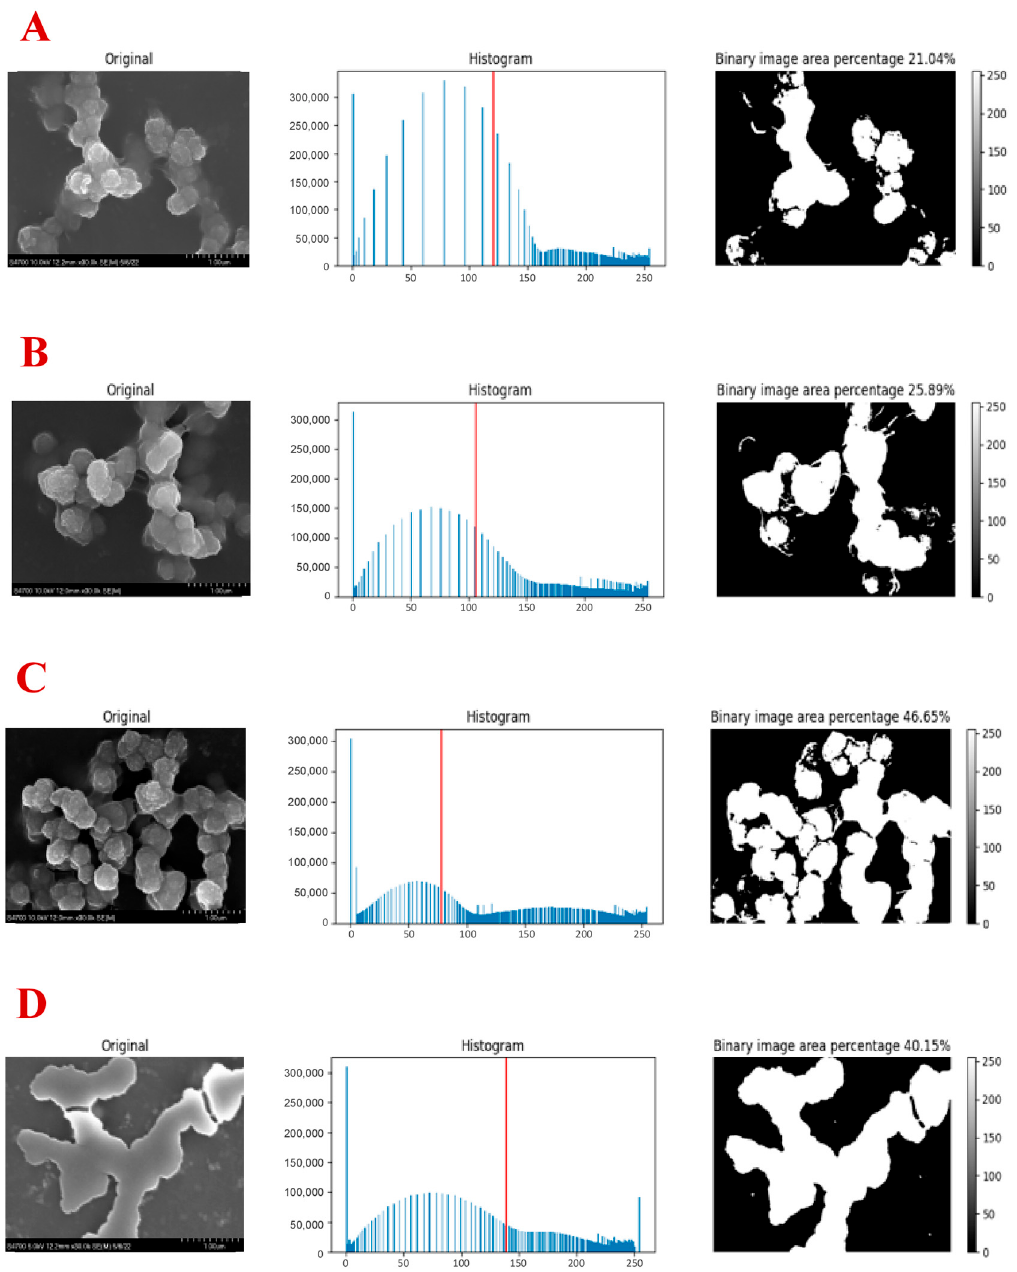
Figure 11. Mineral deposition mapping on SEM of peptide-functionalized collagen samples, magnifi- cation level 30,000 × . The first image, in the 3 × 1 array per condition, is the original SEM image, the second is the histogram of the frequency of pixels per bin (0 to 255) within the SEM image, and the third is the binary conversion of the histogram based on the Multi-Otsu threshold and is indicated by the red line on the histogram. Gradient scale indicated on the right. ( A ) Drop-casted collagen; ( B ) Drop-casted collagen+(CBP); ( C ) Drop-casted collagen+(HABP1); ( D ) Drop-casted collagen+(CBP-HABP1). Solid orange arrows indicate branched columnar mineral growth and dashed cyan arrows show plate-like mineral growth.